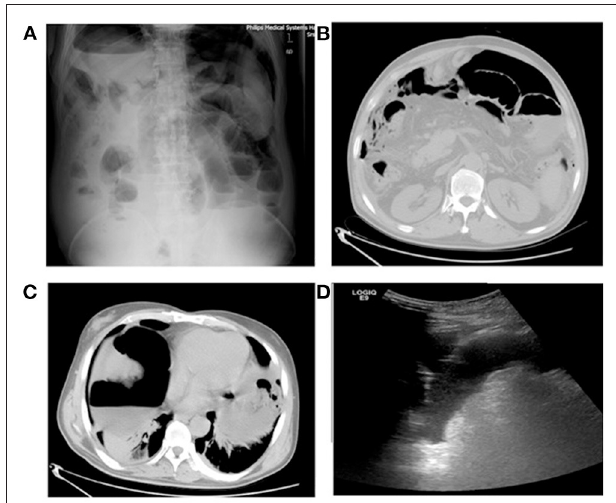
FIGURE 1 | Patient number 1: male, 64 years, hepatocellular carcinoma (S8 segment). Ultrasound examination showed pelvic effusion and poor sound transmission on 4 days after microwave ablation. CT radiography of the abdomen (standing) showed free intraperitoneal air. (A) Radiography of the abdomen (standing) 6 days after microwave ablation. (B) CT 6 days after microwave ablation. (C) CT 6 days after microwave ablation. (D) Ultrasound of the abdomen 4 days after microwave